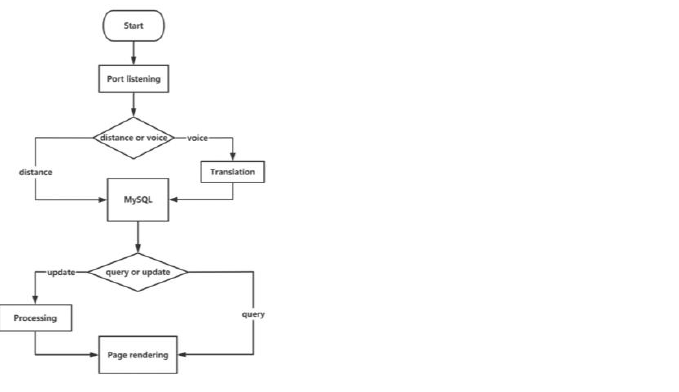
Figure 6. The workflow chart of the cloud information management platform.